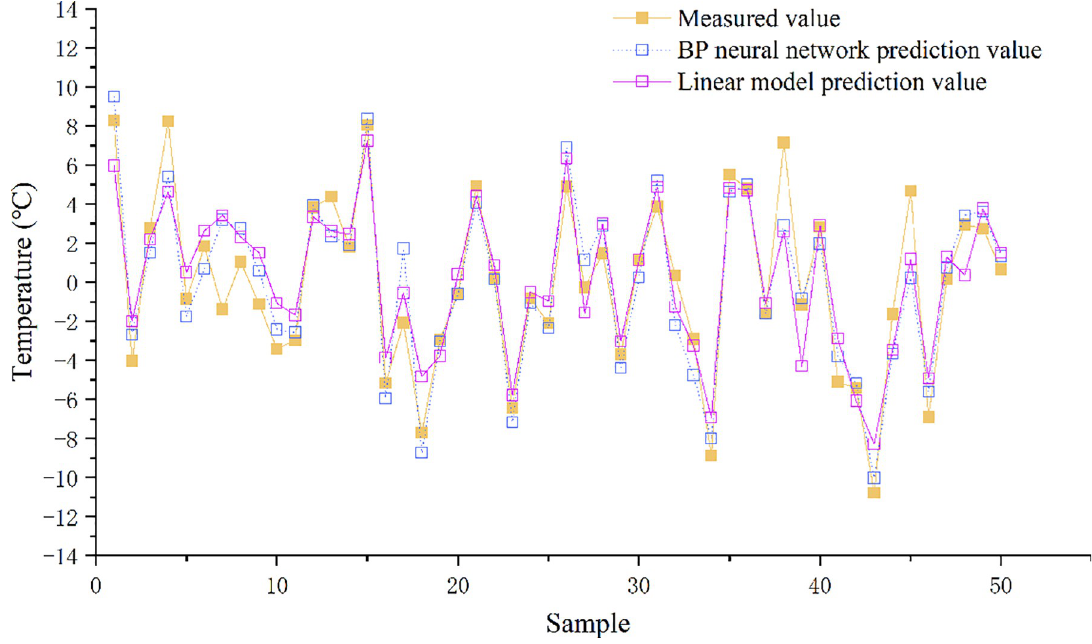
Fig 7. Comparison of predicted and measured values of different